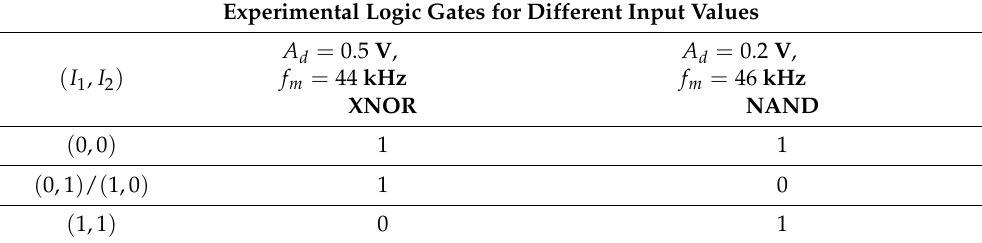
Table 4. With the parameters f m = 44 kHz and A d = 0.5 V an XNOR gate is obtained, while for f m = 46 kHz and A d = 0.2 V a NAND gate is generated. Experimental Logic Gates for Different Input